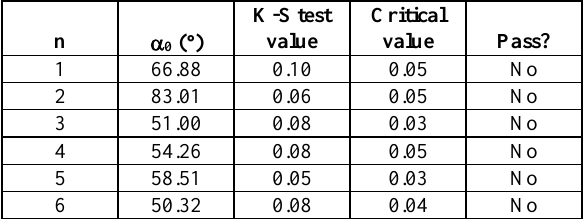
Table 2. Estimated distribution shape parameters and K-S test